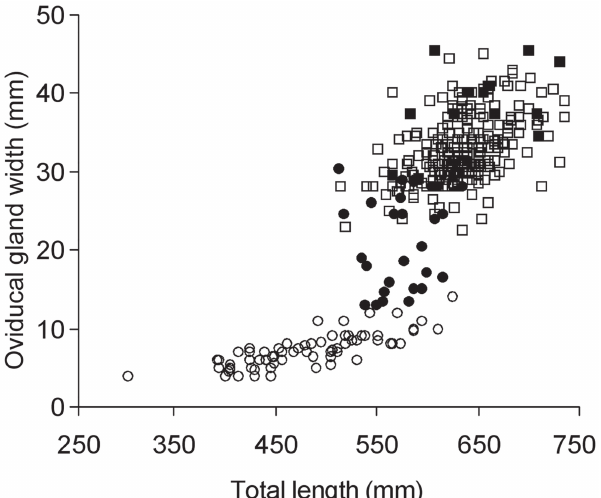
Fig. 5. Total length (TL) and width of the oviducal gland (OGW) relationship of Sympterygia bonapartii from San Matías Gulf (Argentina). Immature (○) n = 69, maturing (●) n = 30, mature (□) n = 263 and mature females with egg capsules (■) n = 11.